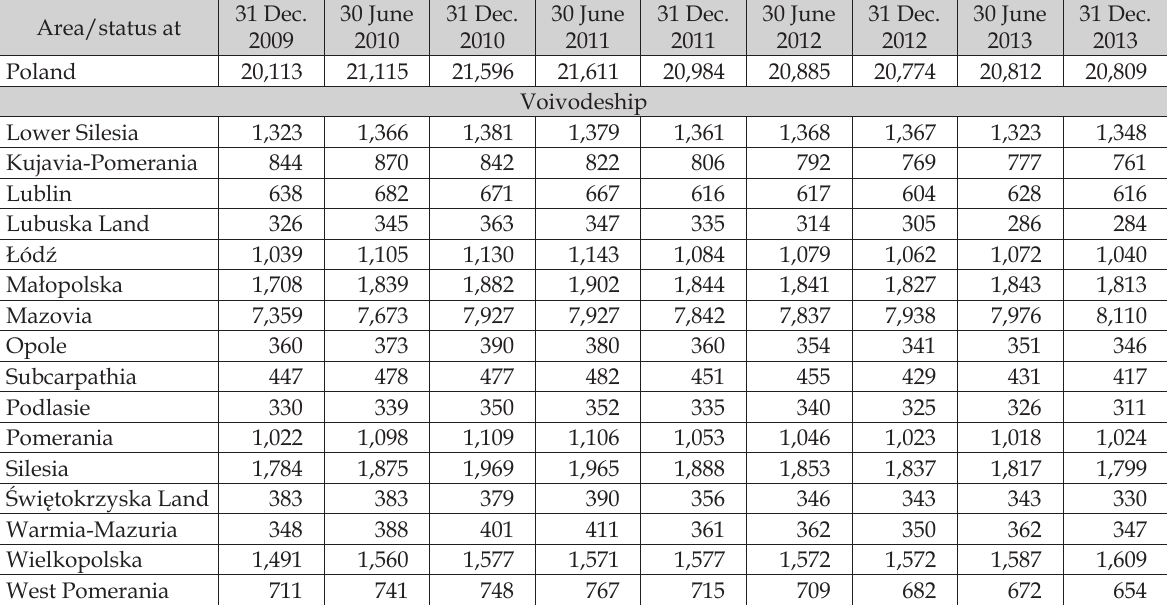
Table 5. Number of entities of the sub-sector of creative production within the creative sector entered into the REGON register in the years 2009–2013. Area/status at